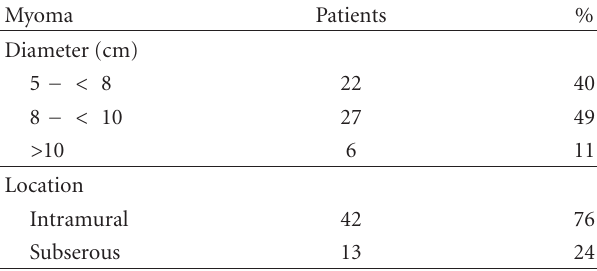
Table 2: Distribution of myomas according to location and